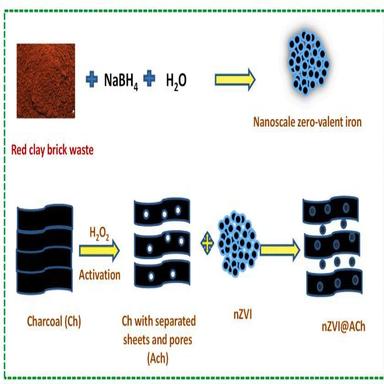
Illustration of steps used for the preparation of nZVI@ACh.